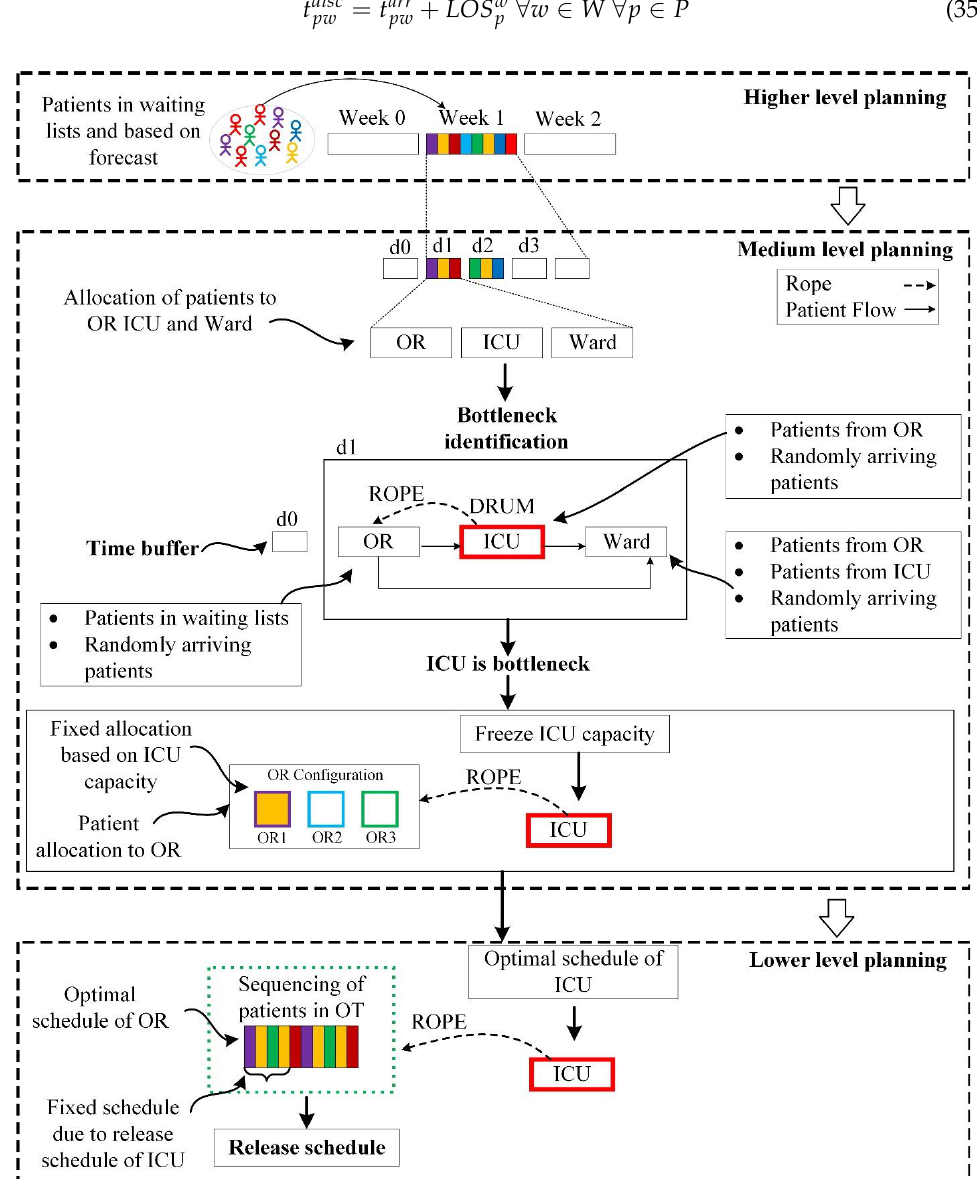
Figure 4. Multi-level integrated planning when the ICU is the bottleneck.